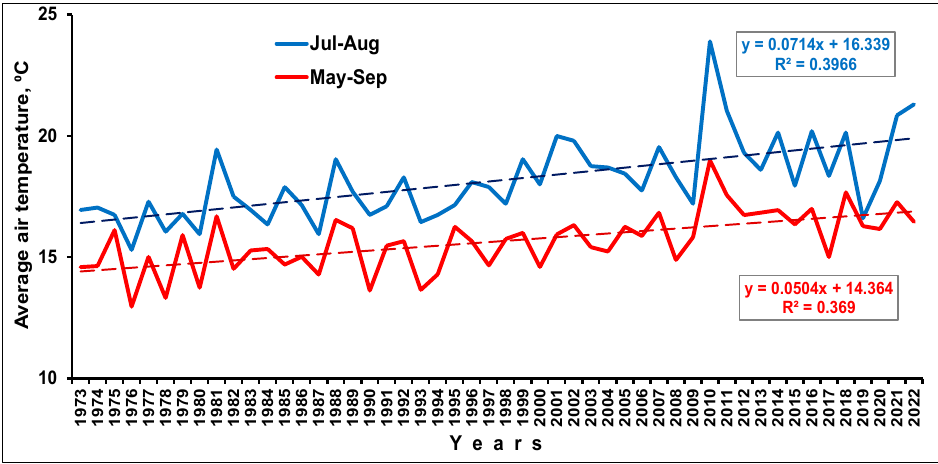
Figure 10. Average air temperature through July–August and May–September over the past 50 years from 1973 to 2022 with linear trends and their parameters.